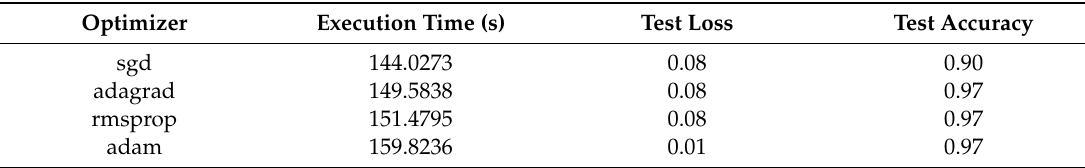
Table 23. E ff ect of adaptive learning rate on SNN.